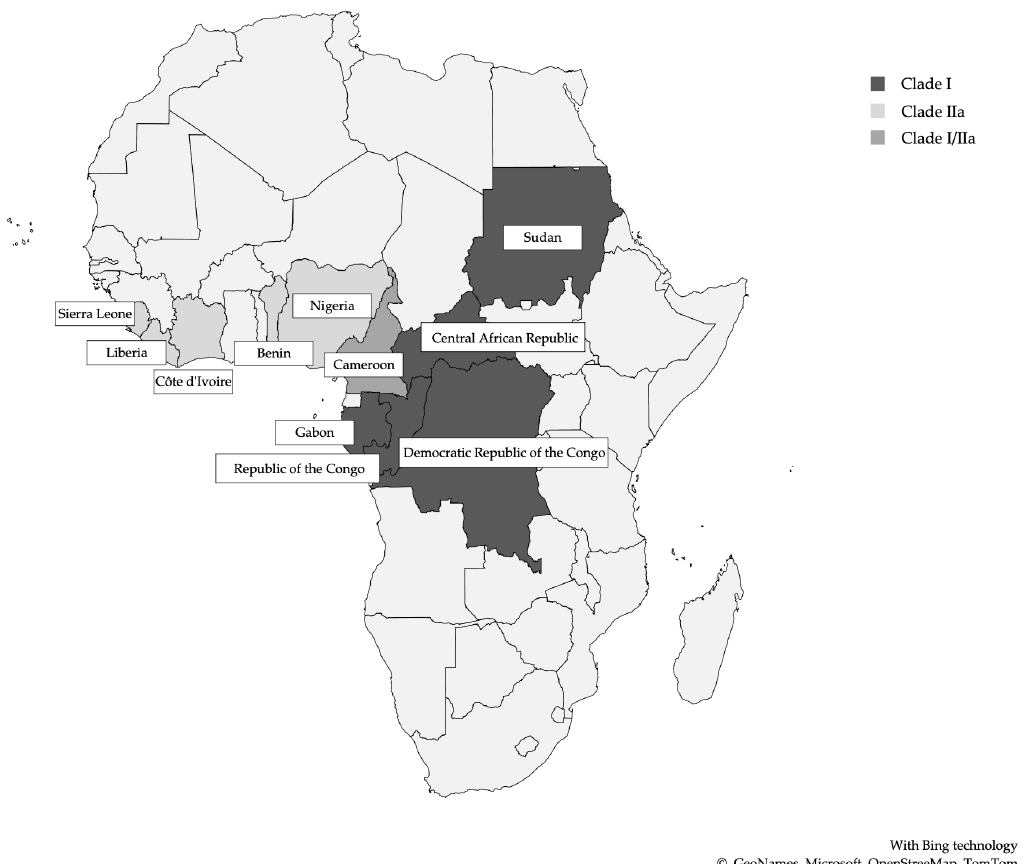
Figure 1. African countries with reported Monkeypox cases and clades (1970–2022) (adapted from [14]).